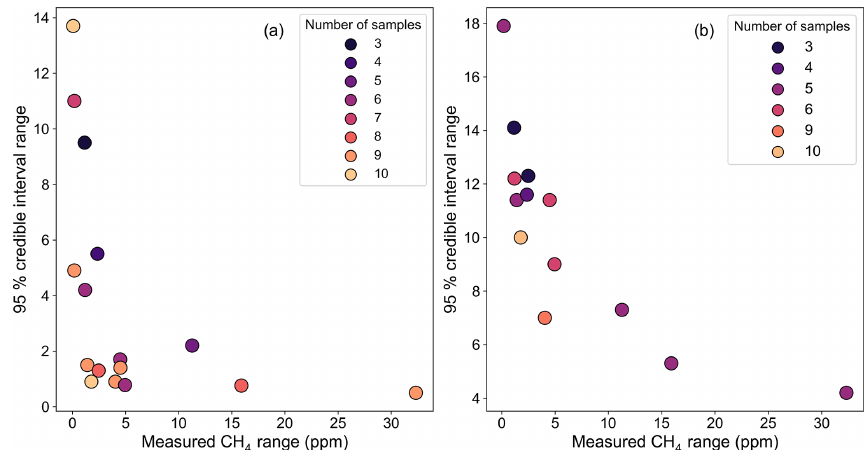
Figure A8. Dependency between the 95% credible interval range of δ 13 C (a) and δ D (b) derived from the Keeling plot method and number of samples and measured CH 4 mole fraction range from the corresponding measured